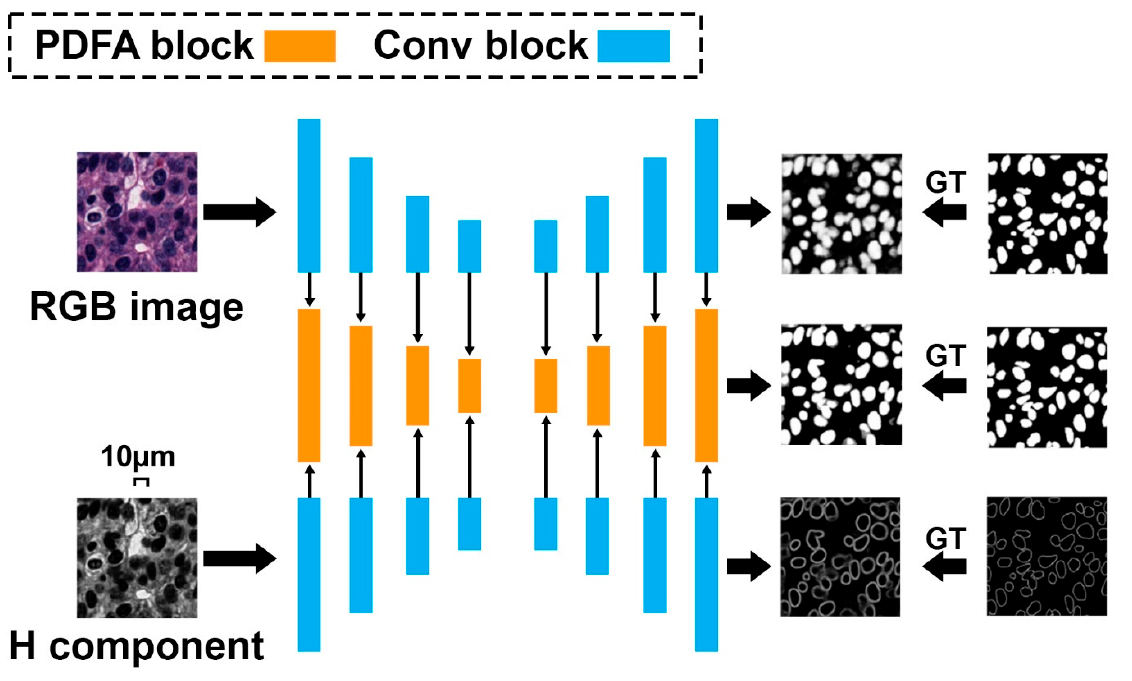
Figure 6. Triple U-Net: hematoxylin-aware nuclei segmentation with progressive dense feature ag- gregation.